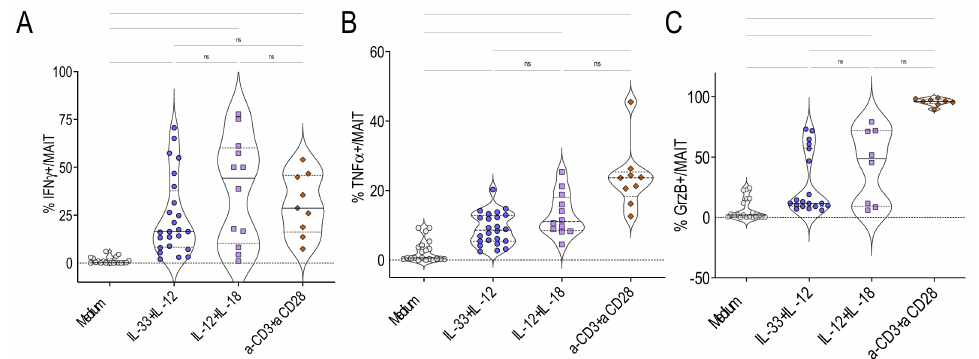
Figure 3. TCR, IL-33+IL-12 and IL-12+IL-18 promote cytokine production by human MAIT cells. ( A – C ) Percentages of IFN γ + (A), TNF α + (B) and GrzB+ (C) cells among gated MAIT cells stimulated for 48 h with IL-12+IL-33 or IL-12 + IL-18 or anti-CD3 + anti-CD28 beads. Bars indicate medians and quartiles. Data were acquired from four or six donors in two or four